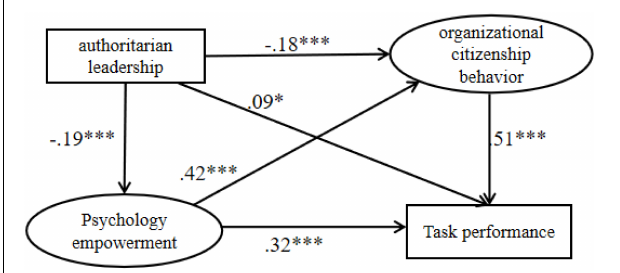
FIGURE 3 | The serial mediation model between authoritarian leadership and task performance. * p < 0.05, and *** p < 0.001.